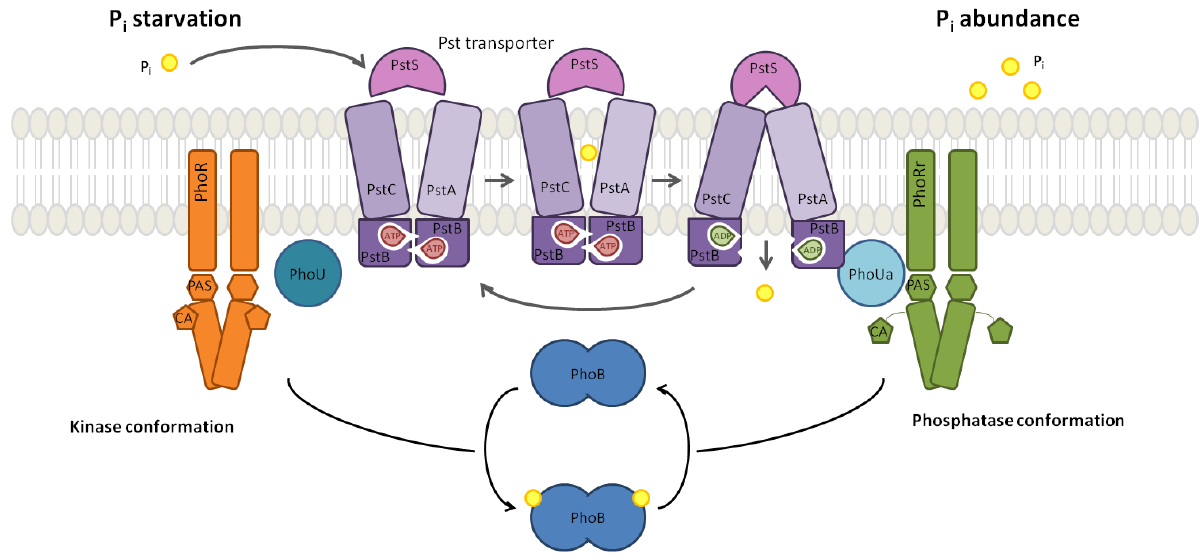
Figure 1. The mechanism of PhoBR TCS response to different environmental conditions. The figure summarises the phosphate response mechanism of the PhoBR TCS. The Pst transporter’s conformational change is based on an ATP-switch model; the outward- and inward-facing conformations signal P i starvation and abundance, respectively. PhoU mediates the interaction between the transporter and PhoR. When external P i is high, PhoU may interact with PhoR through both the PAS and CA domains leading to PhoR phosphatase conformation. Figure adapted from in